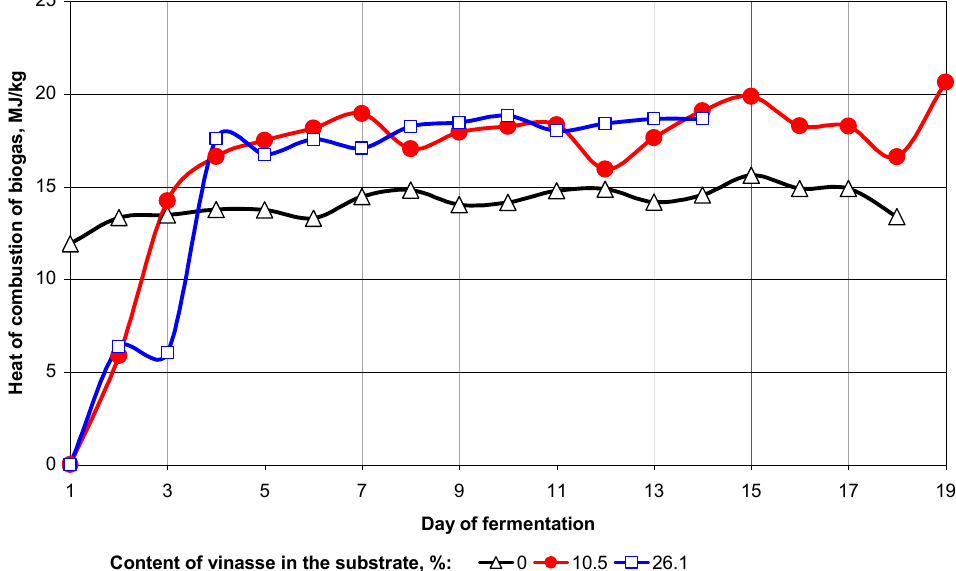
Figure 6. Dynamics of changes in heat of combustion of biogas over time.